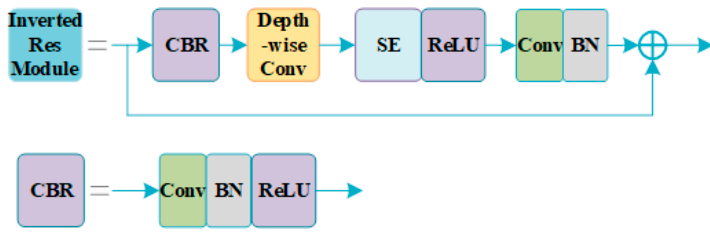
Figure 2. Structure of the inverted residual